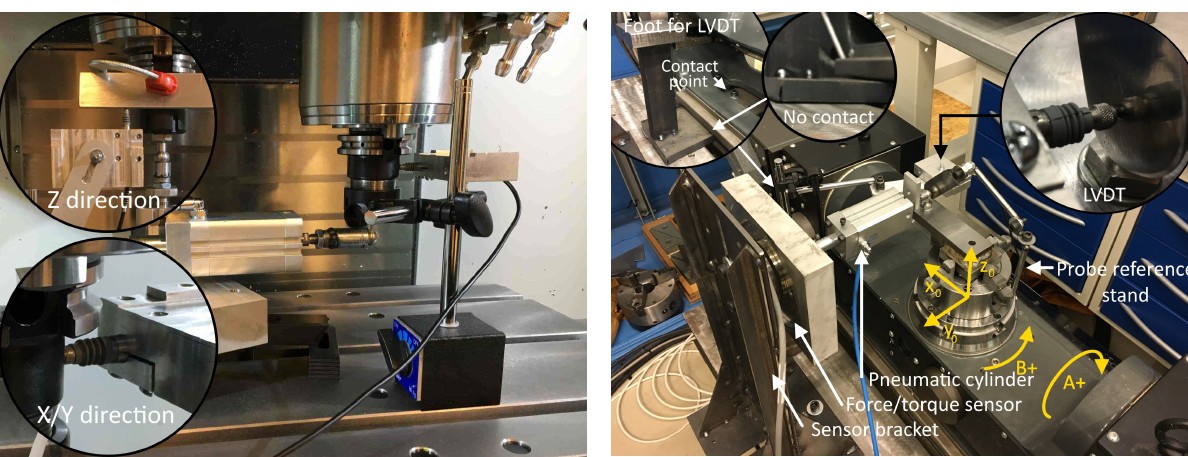
Figure 8: 3-axis CNC, test 1.3: Test setup using So- lartron ax/1/s LVDT.